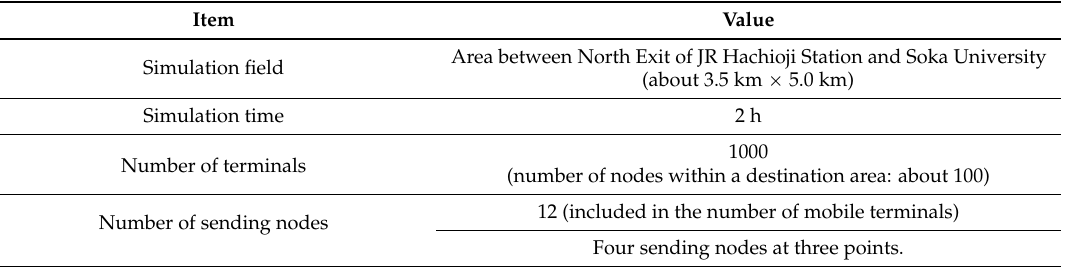
Table 3. Common simulation conditions for evaluation.